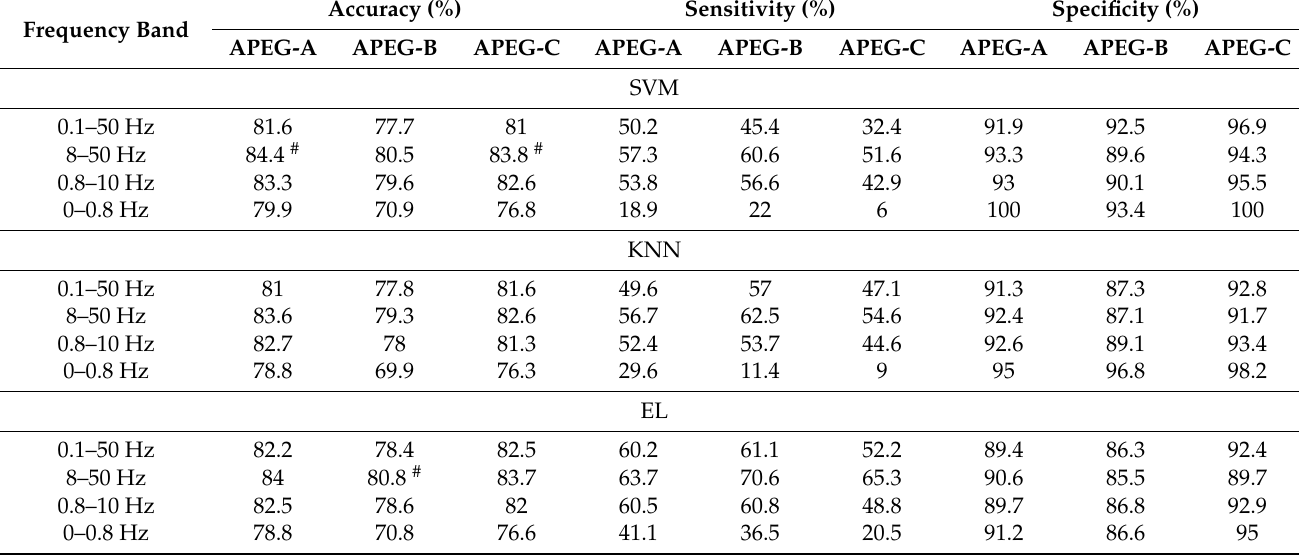
Table 4. Five-fold cross-validation classification performance using a 60 s time window for